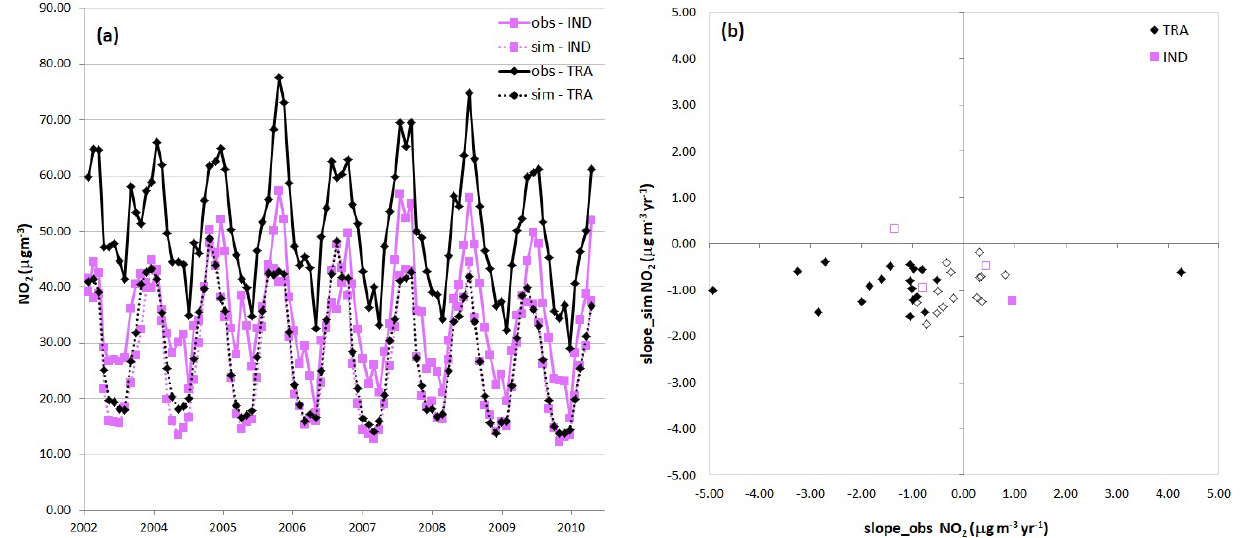
Figure 5. (a) Observed (solid line) and simulated (dashed line) monthly means of NO 2 concentrations (in µgm − 3 ) for all the traffic (black diamond) and industrial (pink square) monitoring stations. (b) Scatter plot of observed and simulated slopes (in µgm − 3 yr − 1 ) at each individual station. Sites where significant slopes are estimated for both observations and simulated data are indicated with a filled